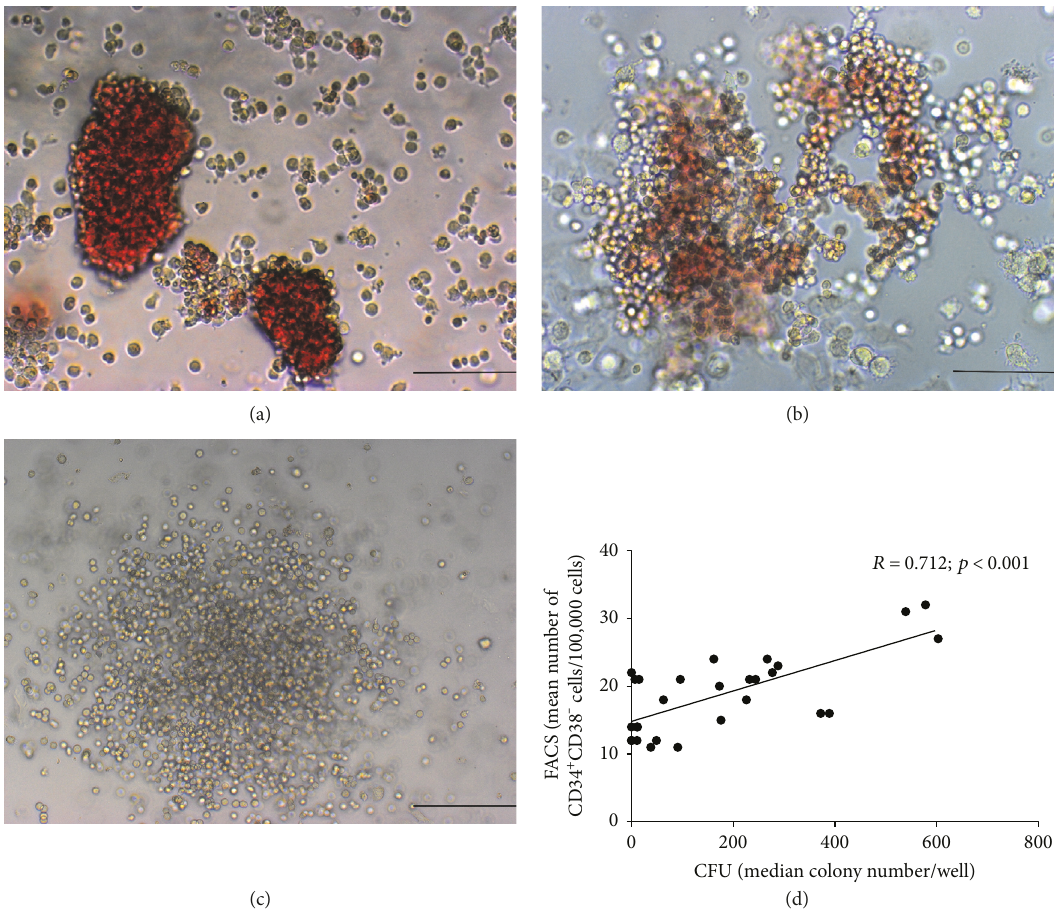
Figure 3: Analysis of the hematopoietic stem cell compartment. (a), (b), and (c) BFU-E, CFU-GEMM, and CFU-GM colonies, respectively, analyzed in the colony assay (original magni fi cation: × 200). (d) Flow cytometry (FACS) and the colony assay (CFU) showed good correlation in the determination of HSC frequencies. Scale bar: 100 μ